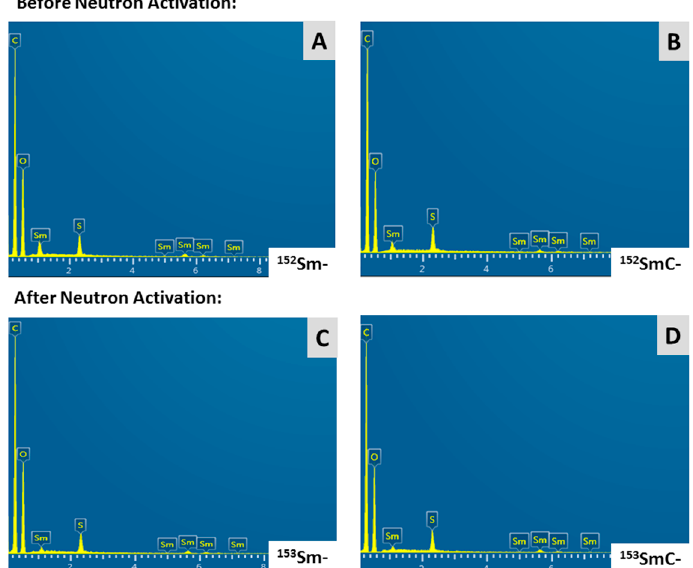
Figure 4. Energy dispersive X-ray (EDX) spectra of the of the Sm- and SmC-labeled microspheres both before ( A , B ) and after ( C , D ) 6 h neutron activation show the presence of chemical elements (i.e., carbon (C), oxygen (O), sulphur (S), and samarium (Sm)) in the samples. No chemical impurities were found after neutron activation.